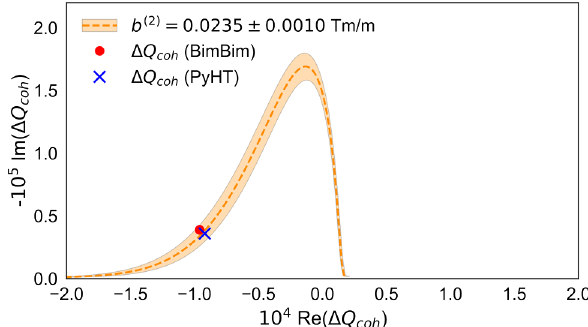
FIG. 12. The dashed line is the stability diagram obtained by numerically solving the approximate dispersion relation in Eq. (9) for an rf quadrupole with b ð 2 Þ ¼ 0 . 0235 (cid:3) 0 . 0010 Tm = m. The colored area is the corresponding resolution of the scan in b ð 2 Þ . The unperturbed complex coherent tune shifts from B im B im (red circle) and from P y HEADTAIL (blue cross) are shown as Eq. (9) is solved numerically for the parameters of the P y HEADTAIL simulation. The outcome is presented in Fig. 12. The red and blue markers are again the complex coherent tune shifts obtained with the B im B im code and P y HEADTAIL respectively. The dashed line marks the stability diagram for an rf quadrupole strength of b ð 2 Þ ¼ 0 . 0235 (cid:3) 0 . 0010 Tm = m. The colored area corre-